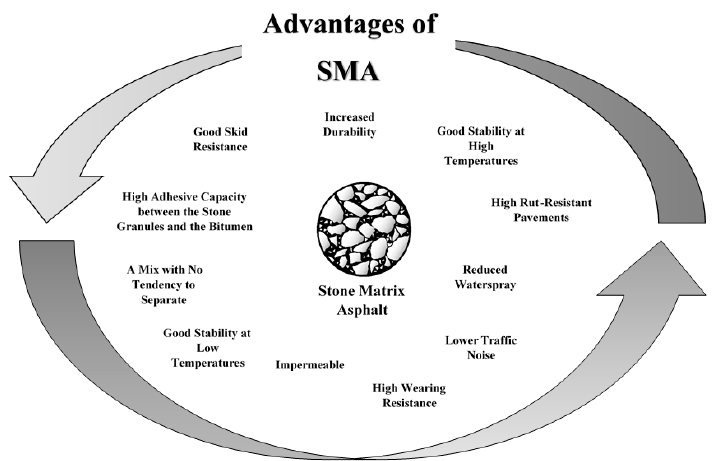
Figure 1. Stone mastic asphalt (SMA) advantages.